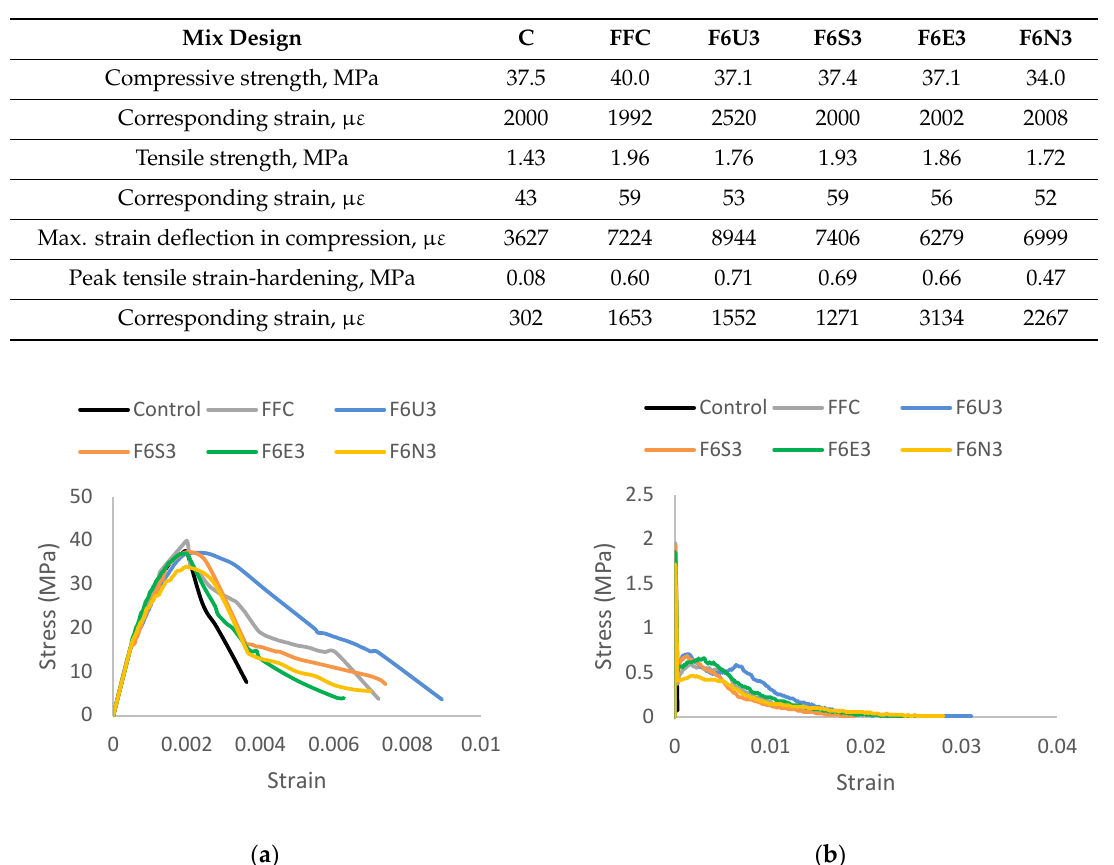
Table 12. Comparison between the developed HyFRC.